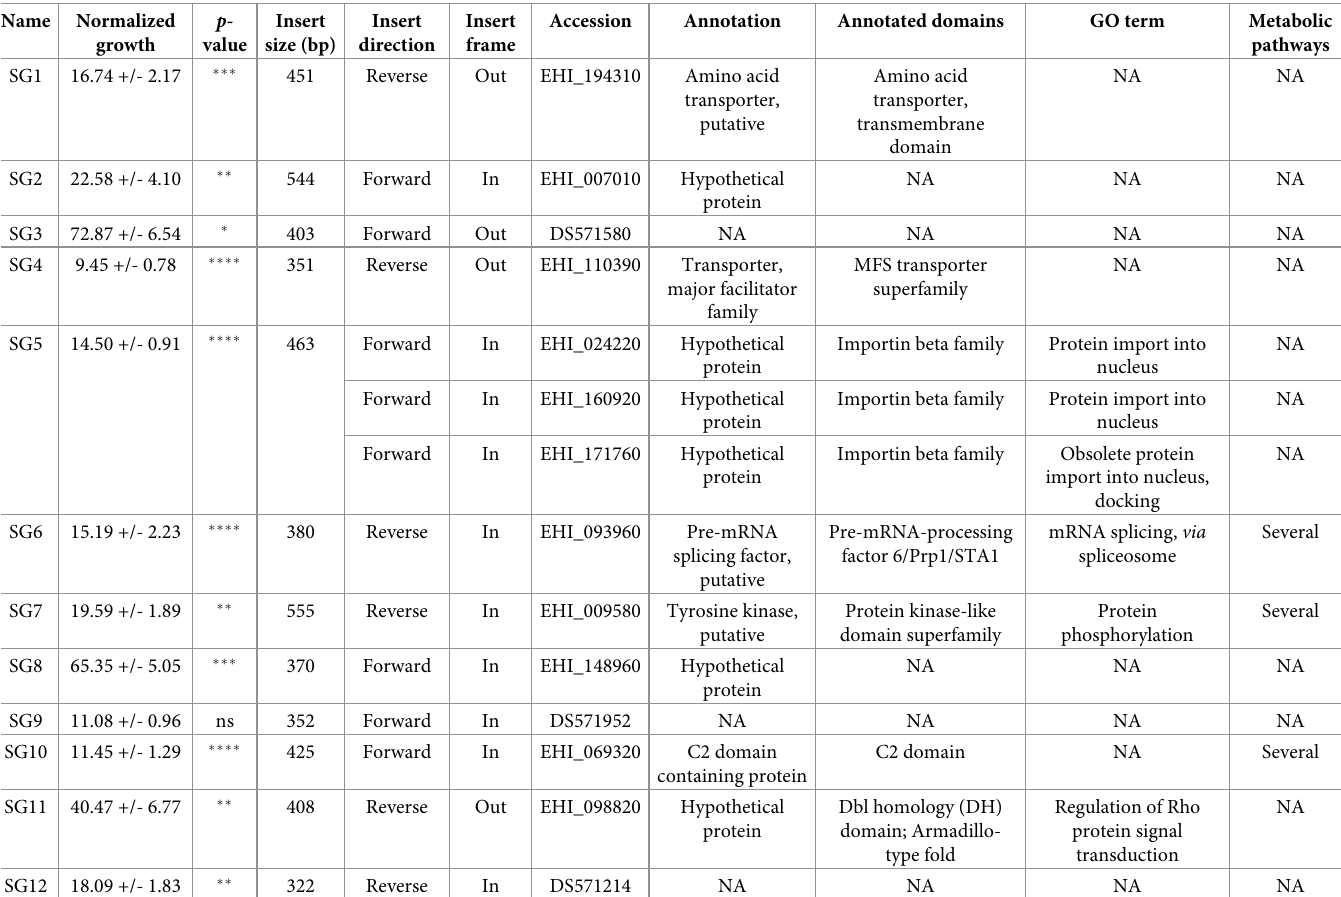
Table 2. Identified slow growth mutants. Summary of growth phenotypes of SG1 –SG12 slow growth mutants, and analysis of the sequences present in each correspond- ing library plasmid. Growth values represent cell numbers normalized to vector control transfectants on day 4 of growth assays. The corresponding raw data growth assay data are found in Figs 5A, S12A, S12C and S12E). Mutants exhibited statistically significant growth defects relative to vector control transfectants; p -values from ANOVA analyses are shown (see S12A, S12C and S12E Fig). The insert sizes are shown in bp. Insert directionality relative to the corresponding coding sequence in the annotated genome is shown. Insert frame relative to the trigger sequence in the pTriggerAdaptor is shown. The accession numbers for coding sequences that inserts correspond to are indicated, with available annotation information and GO terms for each gene (NA, not applicable). Predicted roles in metabolic pathways are shown; genes that are pre- dicted to function in more than one metabolic pathway are indicated as “several.” These predictions are based on data from KEGG Metabolic Pathways (https://www.kegg. jp), the MetaCyc Metabolic Pathway Database [43], and Chemical Entities of Biological Interest (ChEBI) database